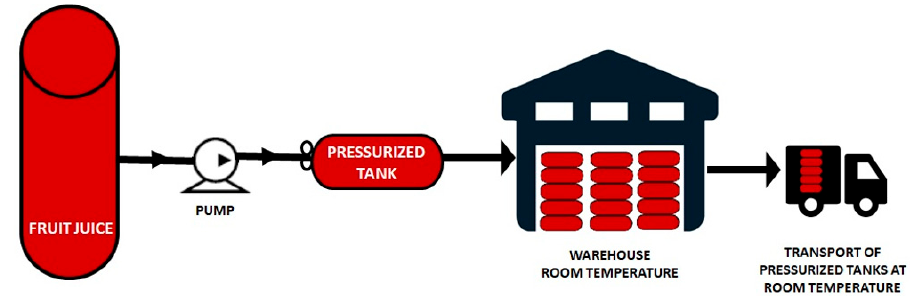
Figure 1. Ideal implementation of hyperbaric storage in a fruit juice factory.